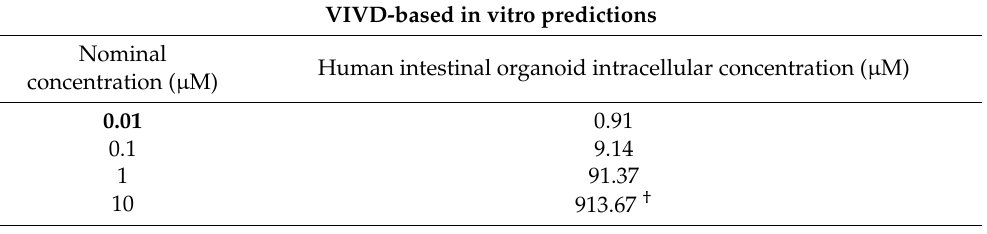
Figure 2. Predicted mean (solid black line) of unbound gefitinib concentration in ( A ) plasma and ( B ) jejunum enterocyte for the last two doses during once daily 250 mg oral dose in human over 14 days. The dashed lines refer to the 95th percentile range of the simulated virtual population (healthy volunteers, aged 20–50 years old, 50% female, n = 100). Table 1. VIVD-Based Predictions of in Vitro Human Intestinal Organoid Intracellular Concentrations at Steady State for Different in Vitro Nominal Concentrations. PBPK-predicted in vivo mean gefitinib maximum concentration at steady state (C max,ss ), minimum concentration at steady state (C min,ss ) and average concentration at steady state (C av,ss ) for once daily dosing of 250 mg oral gefitinib in healthy volunteers (aged 20–50 years old, 50% female, n = 100).